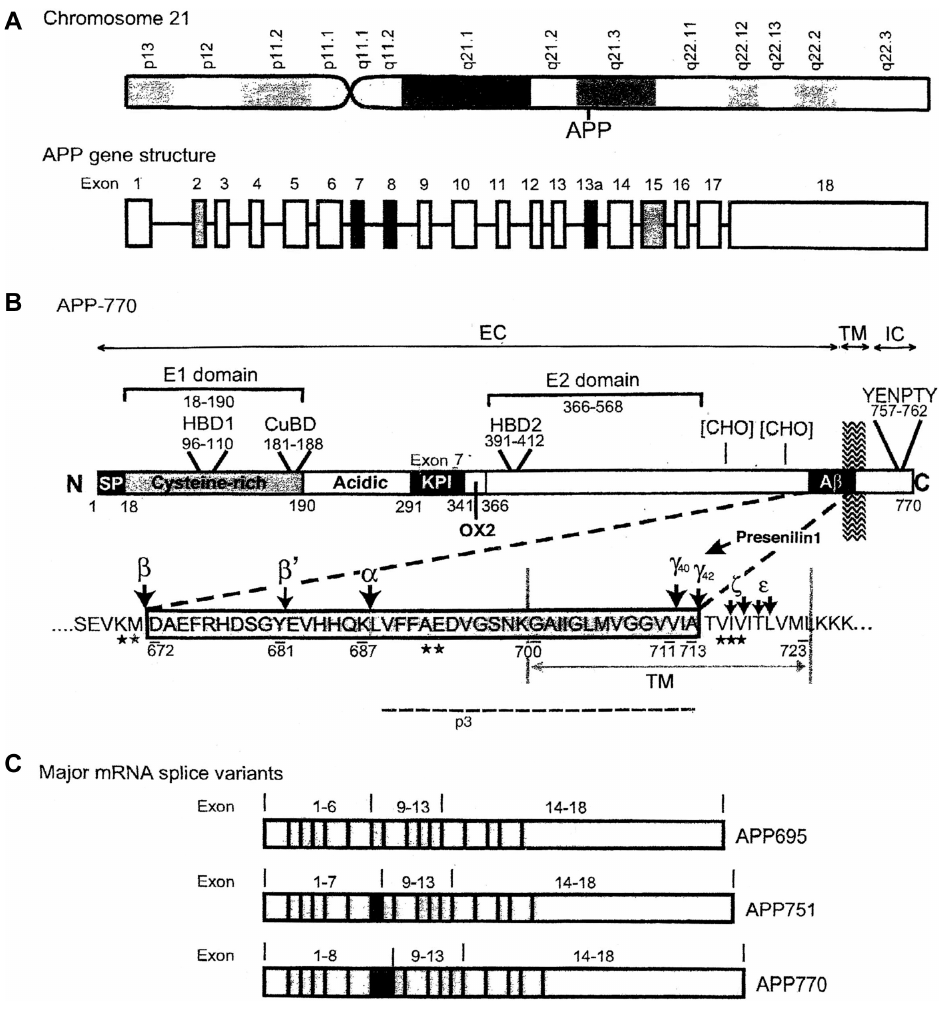
structure and major mRNA splice variants. Figure 1: Structure of the amyloid precursor protein (APP): APP gene, APP 770 (A) APP gene structure. The APP gene is located on chromosome 21q21.2-3, spans approximately 240 kb and contains at least 18 exons. Exon 13a (highlighted in black) denotes a novel exon containing a 59-nucleotide coding region and a 393-nucleotide untranslated region, as published by de Sauvage and Octage [see Ref. (6)]. (B) Protein structure (APP ). APP can be divided into three domains: APP extracellular 770 domain (EC), APP transmembrane domain (TM) and APP intracellular domain (IC). APP has an N-terminal signal peptide (SP); E1 domain with a heparin-binding domain (HBD1), a copper-binding domain (CuBD); acidic region; APP and APP contain a Kunitz protease inhibitor (KPI) 751 770 domain located in exon 7 and an Ox-2 antigen domain; E2 domain with a second heparin-binding domain (HBD2); Between the E2 and A β cleavages sites: BACE cleaves APP after Met ( β ) and Tyr ( β′ ), whereas ADAM10 [best candidate α -secretase, see Ref. (44)] processes 671 681 region (TM) involves presenilin 1 (PS1) and generates A β peptides of mainly 40 and 42 amino acid residues long ( γ ) and ( γ ). PS-dependent 40 42